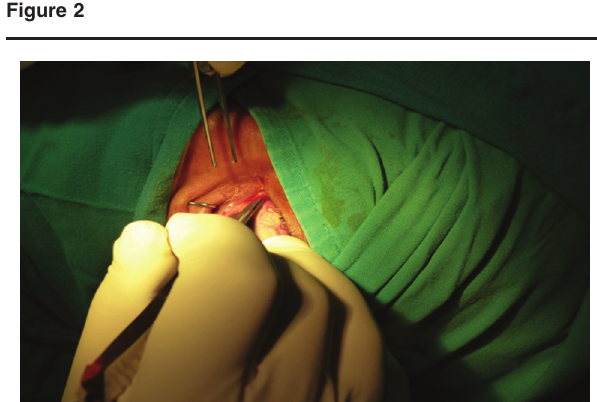
Transcaruncular